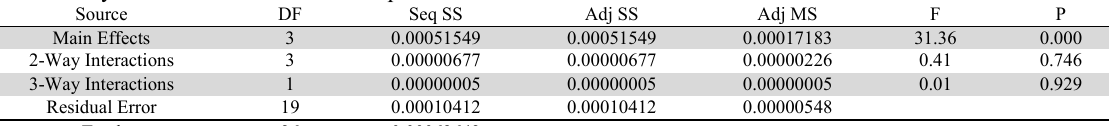
Variance analysis for the raw material sales price